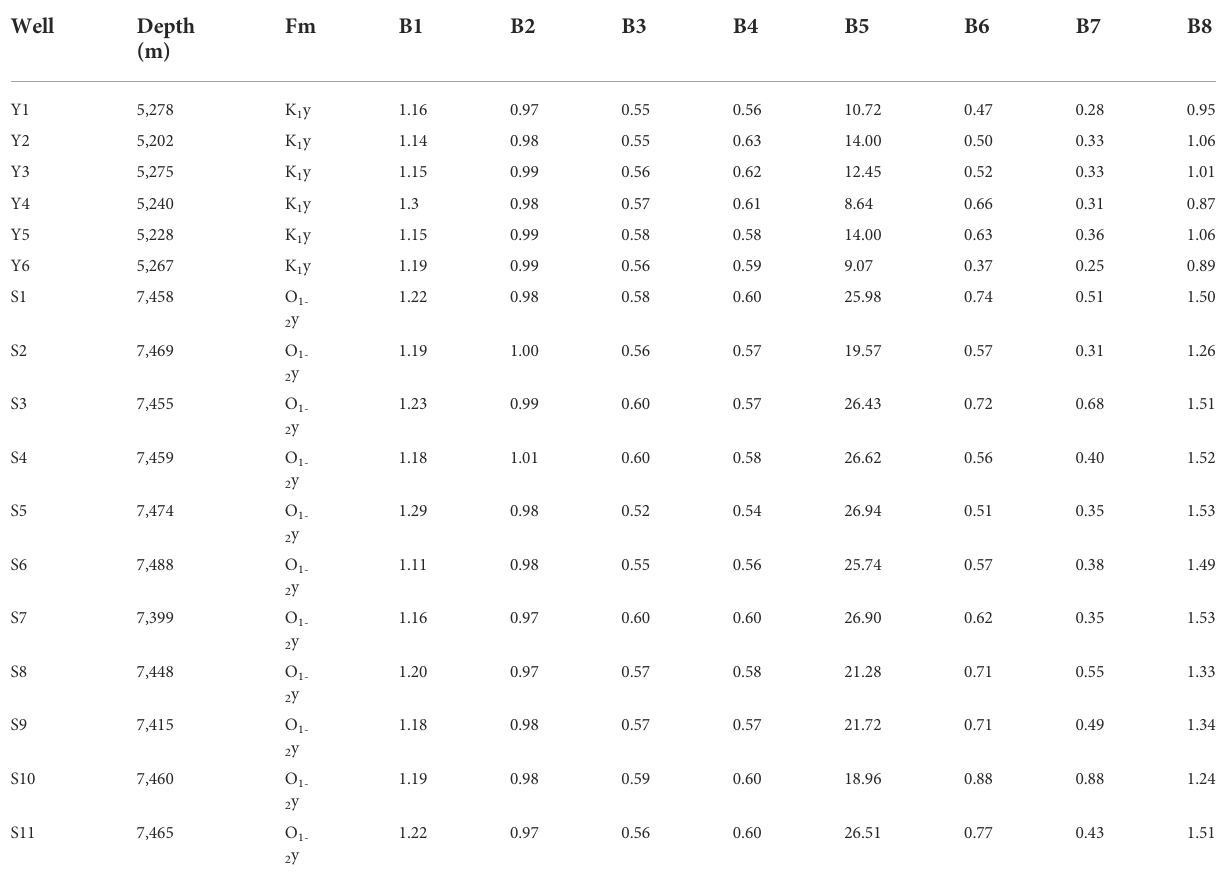
TABLE 2 Maturity parameters of oil samples from Yakela Field and Shunbei Field. Well